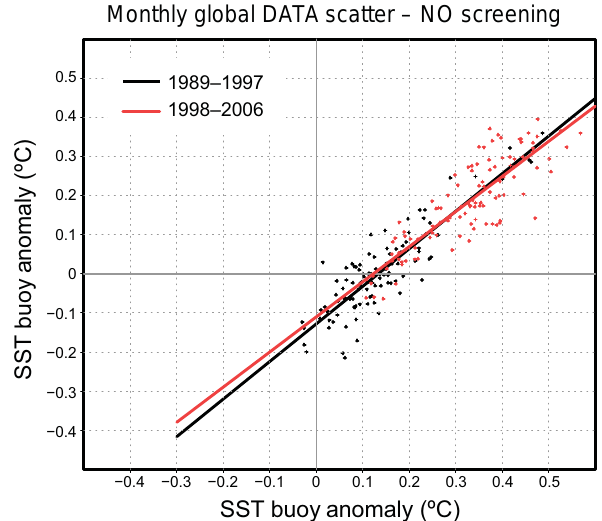
Figure A2. Scatter plot of global collocated average monthly ship vs. buoy anomaly for January 1989–December 2006. The first 9 years are shown in the black and the second 9 years in red. Least squares linear fits for the two periods are also shown.